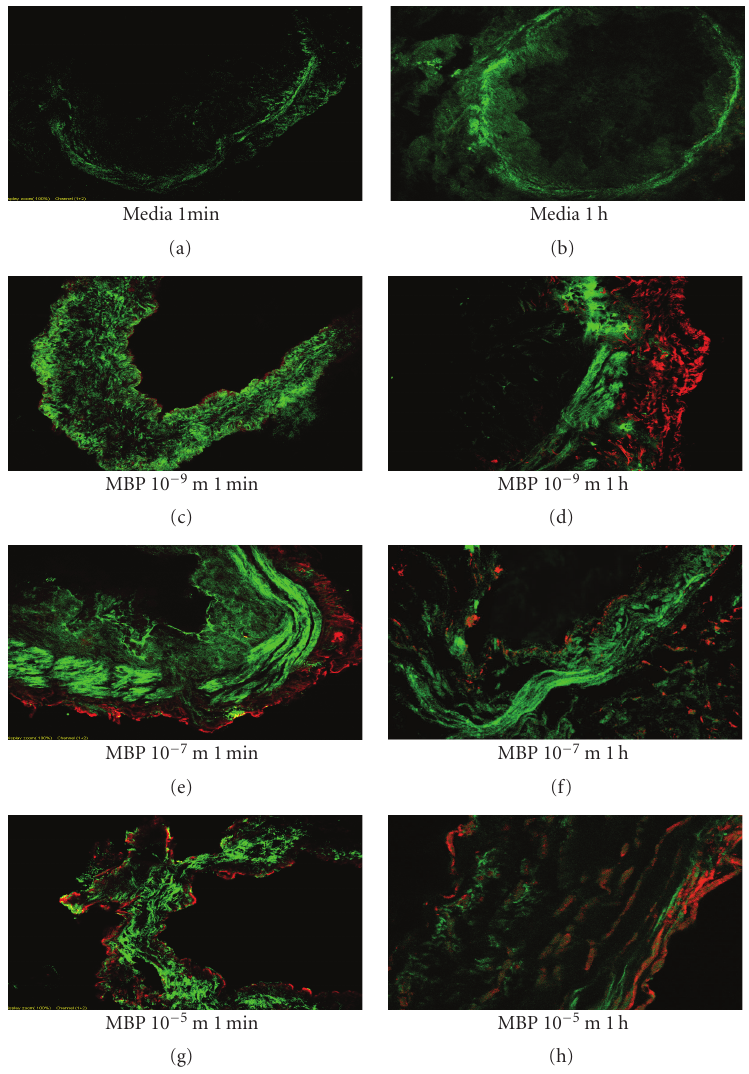
Figure 6: Immunolocalization of exogenously applied MBP in human airway. Results show representative images analyzing the fluorescence of immunolabeled MBP in human airway following incubation with MBP for 1 min and 1 h. Immunoreactive actin (green) and MBP (red) are shown. Brief Exposure . 1min elicited limited MBP deposition to the epithelial and outer surfaces of the airway. However, longer 1h exposure allowed some MBP to access cells within the media of the airway wall. The longer 1h exposure was necessary for immunolocalization to be detected within the smooth muscle layer. This time-dependent e ff ect was increased by greater concentrations of MBP (10 − 5 M) compared to lesser concentrations of MBP (10 − 7 M). In all control tissue no MBP content was detected (confocal microscopy